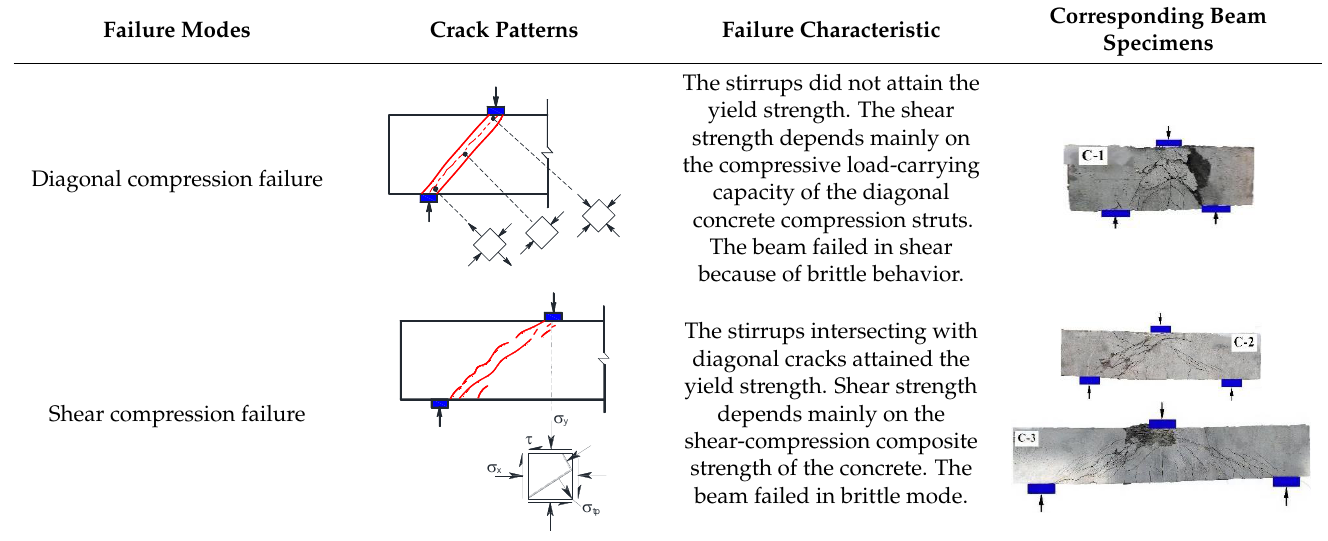
Table 6. Crack patterns and failure modes of RC beams.